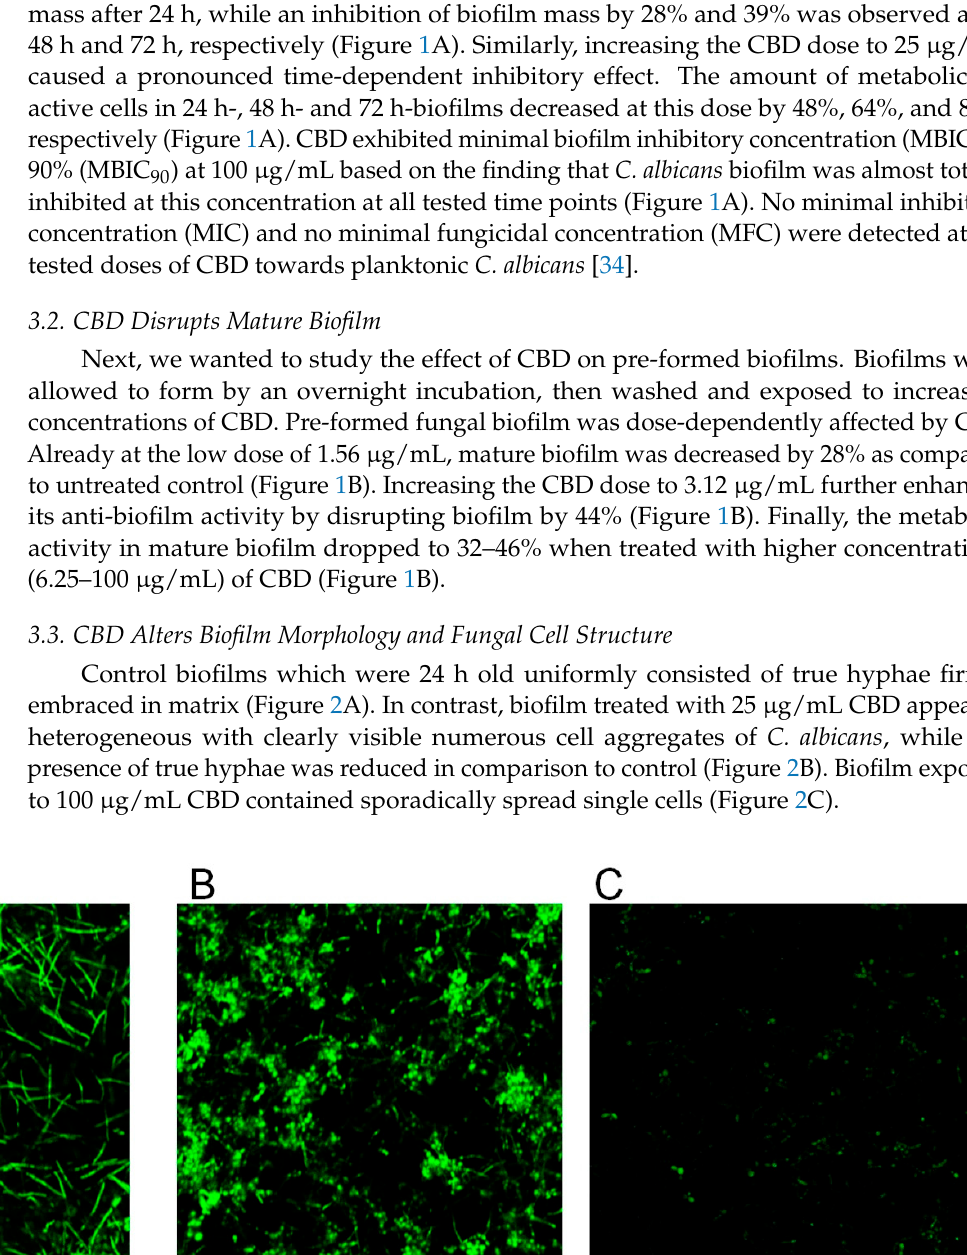
Figure 2. Effect of CBD on biofilm morphology. A–C. C. albicans –GFP biofilm were formed for 24 h in the absence of ( A ), presence of 25 μ g/mL ( B ), or 100 μ g/mL ( C ) CBD. The morphology of biofilms was visualized using NIKON confocal microscope with 488 nm laser excitation and collecting the data using the 535 nm green filter. Magnification 100×.